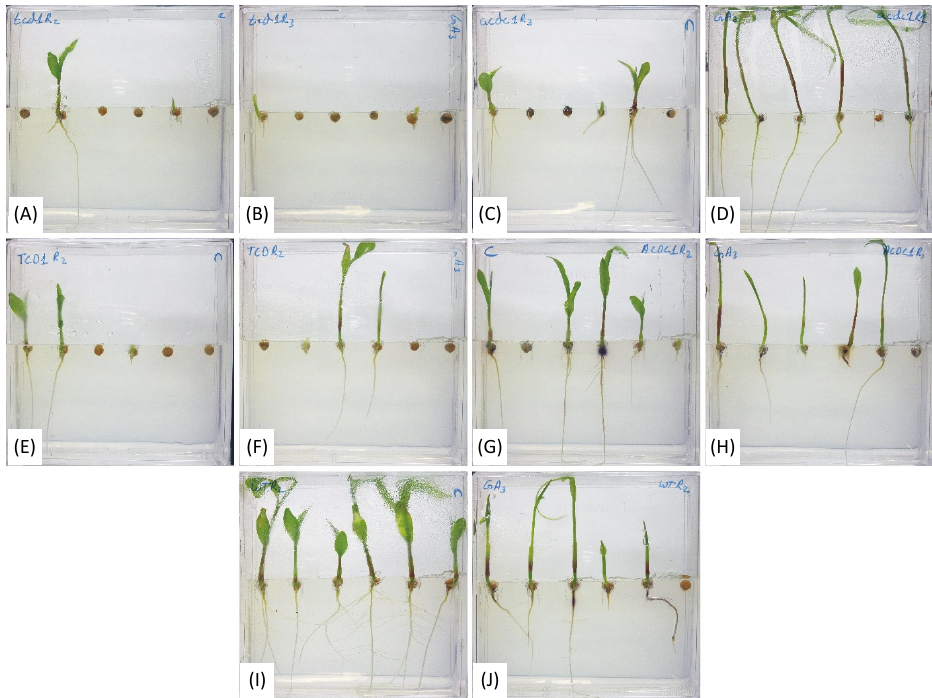
Figure 2. Effect of gibberellic acid (GA 3 ) on five sorghum genotypes eight days after planting; ( A ) and ( B ) are totally cyanide deficient class 1 ( tcd1 ) mutants; ( C ) and ( D ) are adult cyanide deficient 1 ( acdc1 ) mutants; ( E ) and ( F ) are tcd1 siblings (TCD1); ( G ) and ( H ) are acdc1 siblings (ACDC1); ( I ) and ( J ) are elite; ( A ), ( C ), ( E ), ( G ) and ( I ) are control treatment; ( B ), ( D ), ( F ), ( H ) and ( J ) are GA 3 treatment. A movie of the germinating seedlings can be found in Figure S1 and through the following link <https://youtu.be/fNWzvSFqchU> .